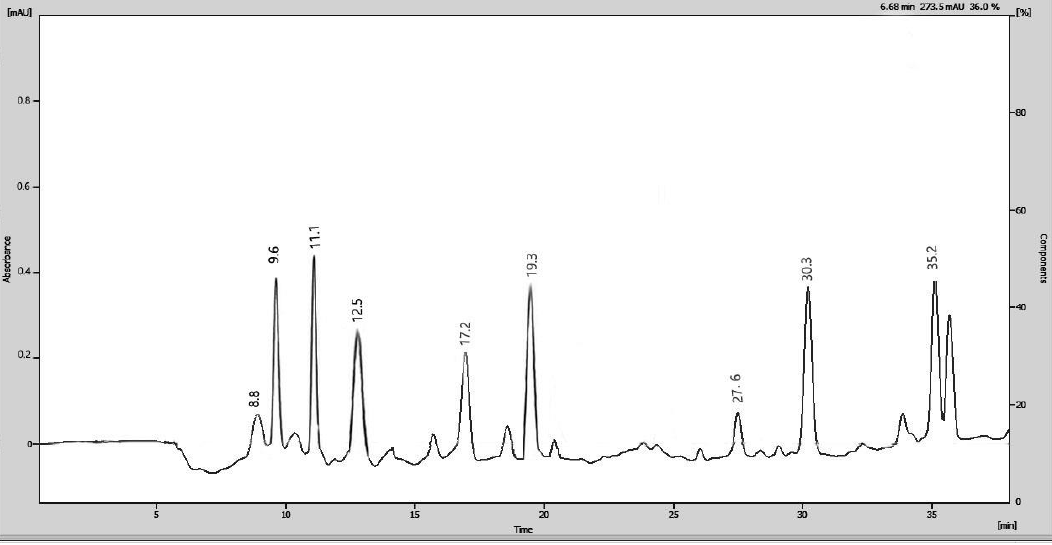
Figure 4. High performance liquid chromatogram (HPLC) analytical of but. aft. hydrolysis fraction .